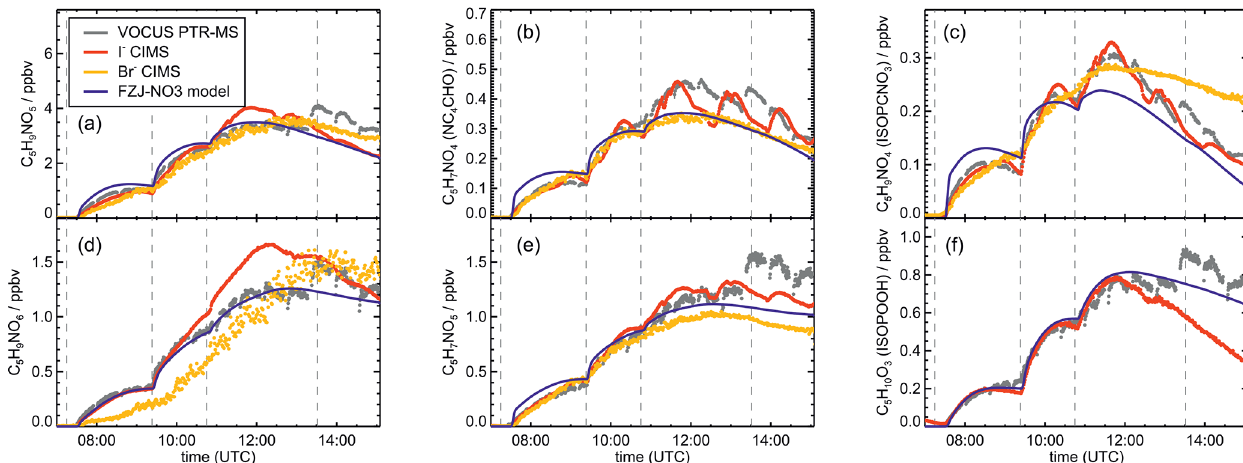
Figure A10. Comparison of reported signals from three mass spectrometer instruments applying different ionization methods (Vocus PTR- MS, Br − CIMS, I − CIMS) and measuring organic products in the experiment on 13 August 2018 (Experiment 4). All signals are scaled to match best the concentrations resulting from model calculations applying the FZJ-NO3 chemical mechanism.